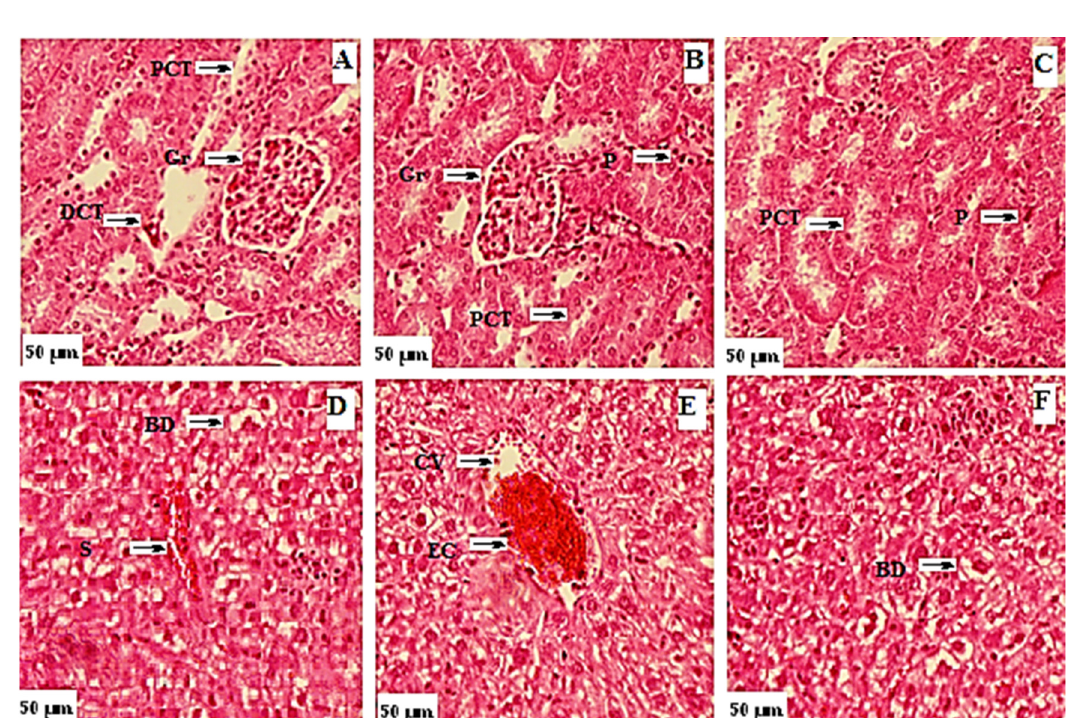
Figure 5. Photomicrograph of kidney and liver from toxicity study of flavonoids. Kidney: ( A ) control group; ( B ) group treated with 3000 mg/kg b.w. of F1 ; ( C ) group treated with 3000 mg/kg b.w. of F5. Gr: glomeruli, PCT: proximal convoluted tubule, DCT : distal convoluted tubule, P: podocyte. Liver: ( D ) control group; ( E ) group treated with 3000 mg/kg b.w. of F1 ; ( F ) group treated with 3000 mg/kg b.w. of F5. BD: bile duct, S: sinusoids, EC : endothelial cells, CV : central vein .